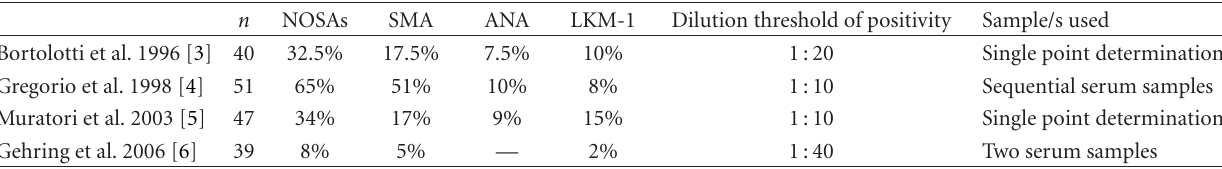
Table 1: Studies investigating the prevalence of nonorgan specific auto-antibodies in children with chronic hepatitis C.